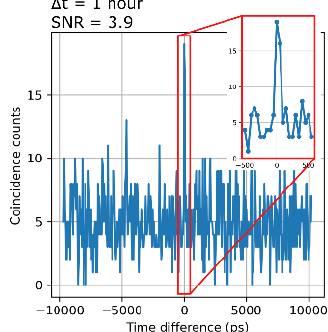
Figure 2. Coincidence counts of a long nanowire integrated over 1 hour and pumping with a cw pump laser at 780 nm with 4 mW incident power. The signal to noise ratio (SNR) is greater than 2 indicating photon pair emission from the